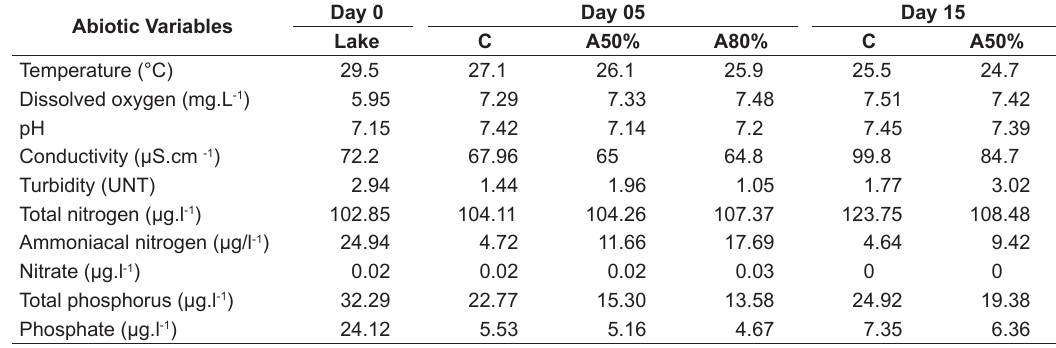
Table 1. Mean values of abiotic variables at the beginning and end of the experiment in the three treatments (Control, Treatment with 50% shading and Treatment with 80% shading).